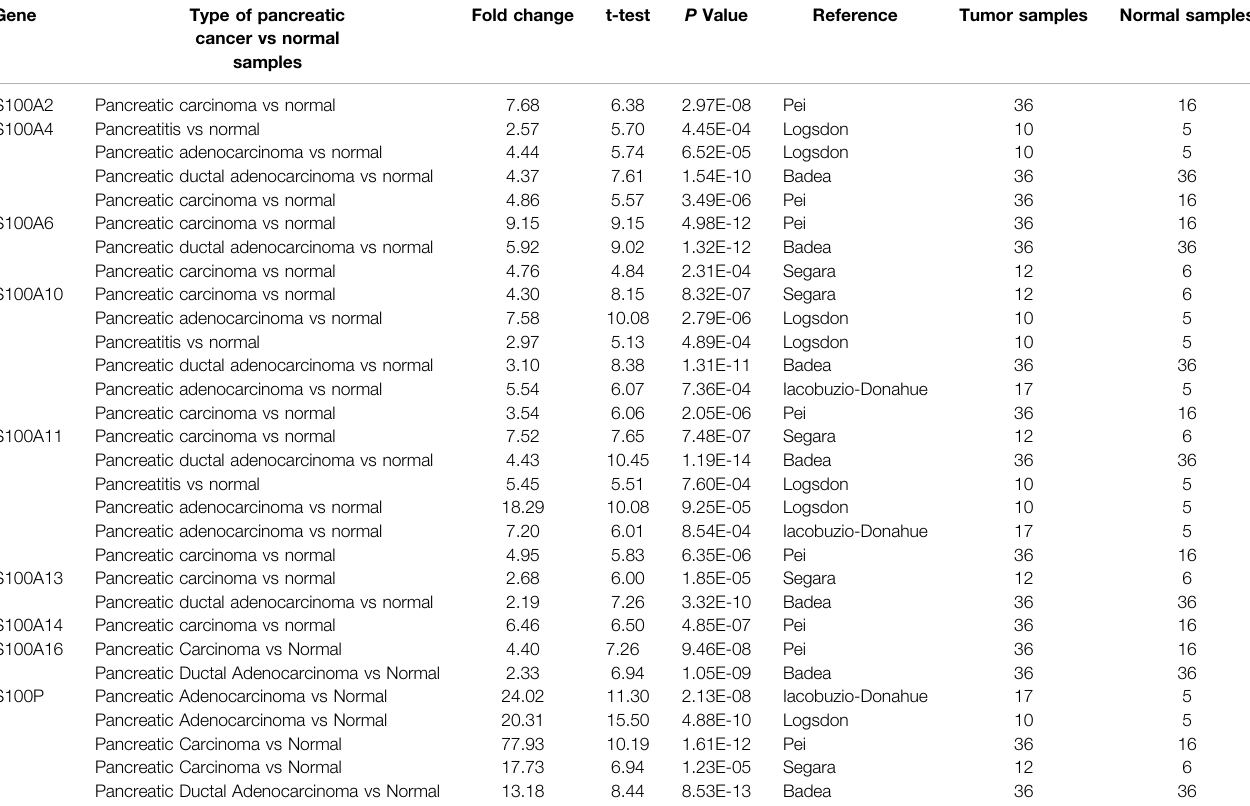
TABLE 1 | Signi fi cant changes in the transcriptional expression of the S100 gene family members between PAAD and pancreatic normal samples (OnCOMine database). Gene Type of pancreatic Fold change t-test P Value Reference Tumor samples Normal cancer vs normal samples